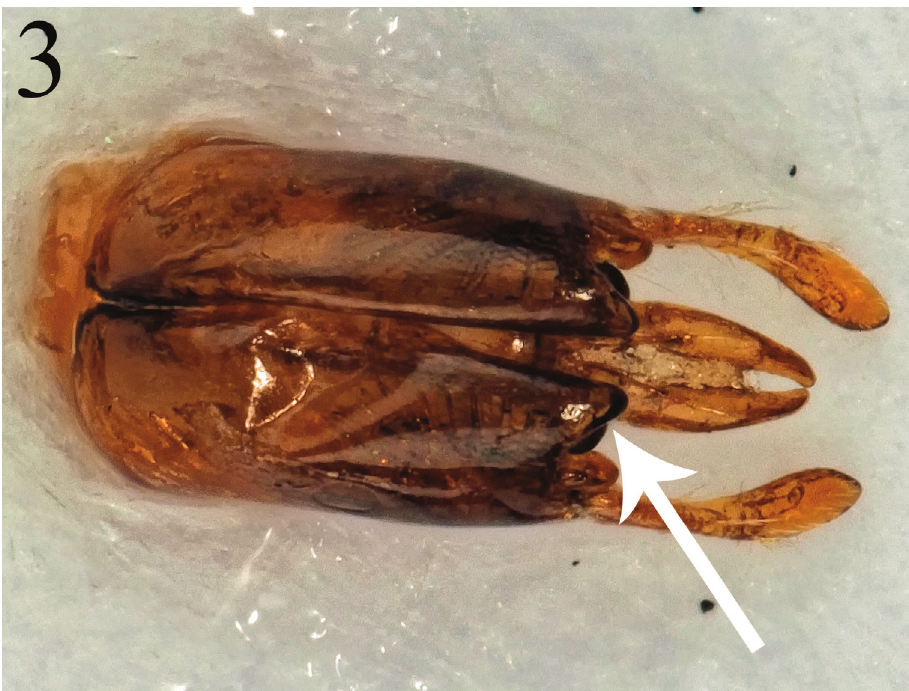
Figure 3. Male genital capsule of Halopanurgus baldocki , with arrow indicating the apical part of the gonocoxa which is produced into a strong triangular